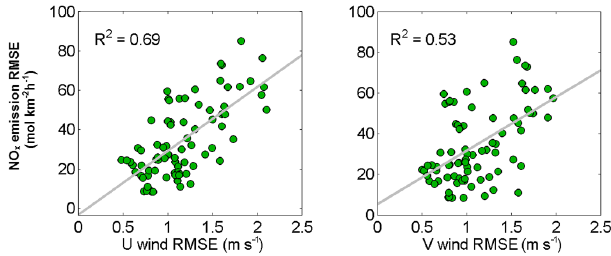
Figure 7. The scatter plot between the prior RMSE of boundary layer wind vectors and urban NO x emission posterior RMSE over the 4-day daytime assimilation time period in